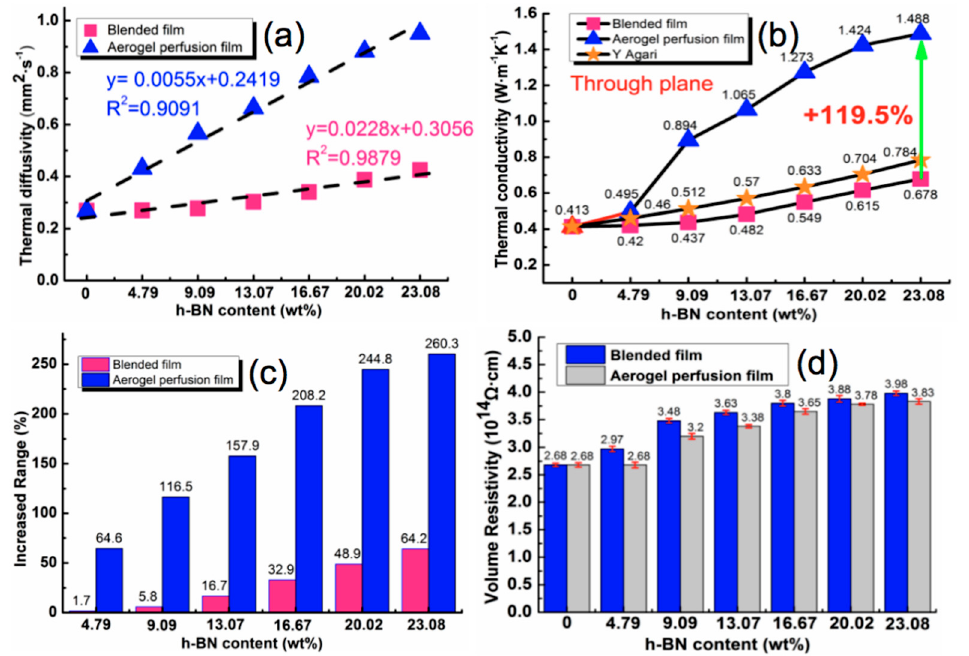
Figure 6. The e ff ects of h-BN loading on ( a ) Thermal di ff usivity, ( b ) Thermal conductivity, ( c ) Increased Figure 6. The effects of h-BN loading on ( a ) Thermal diffusivity, ( b ) Thermal conductivity, ( c ) range of thermal conductivity, ( d ) The e ff ects of h-BN loading on volume Increased range of thermal conductivity, ( d ) The effects of h-BN loading on volume resistivity.